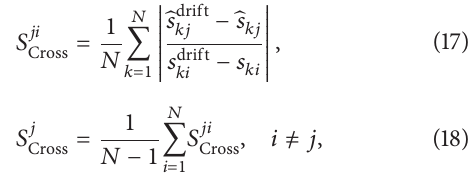
Figure 13: Comparison of spillover effects against increasing offset